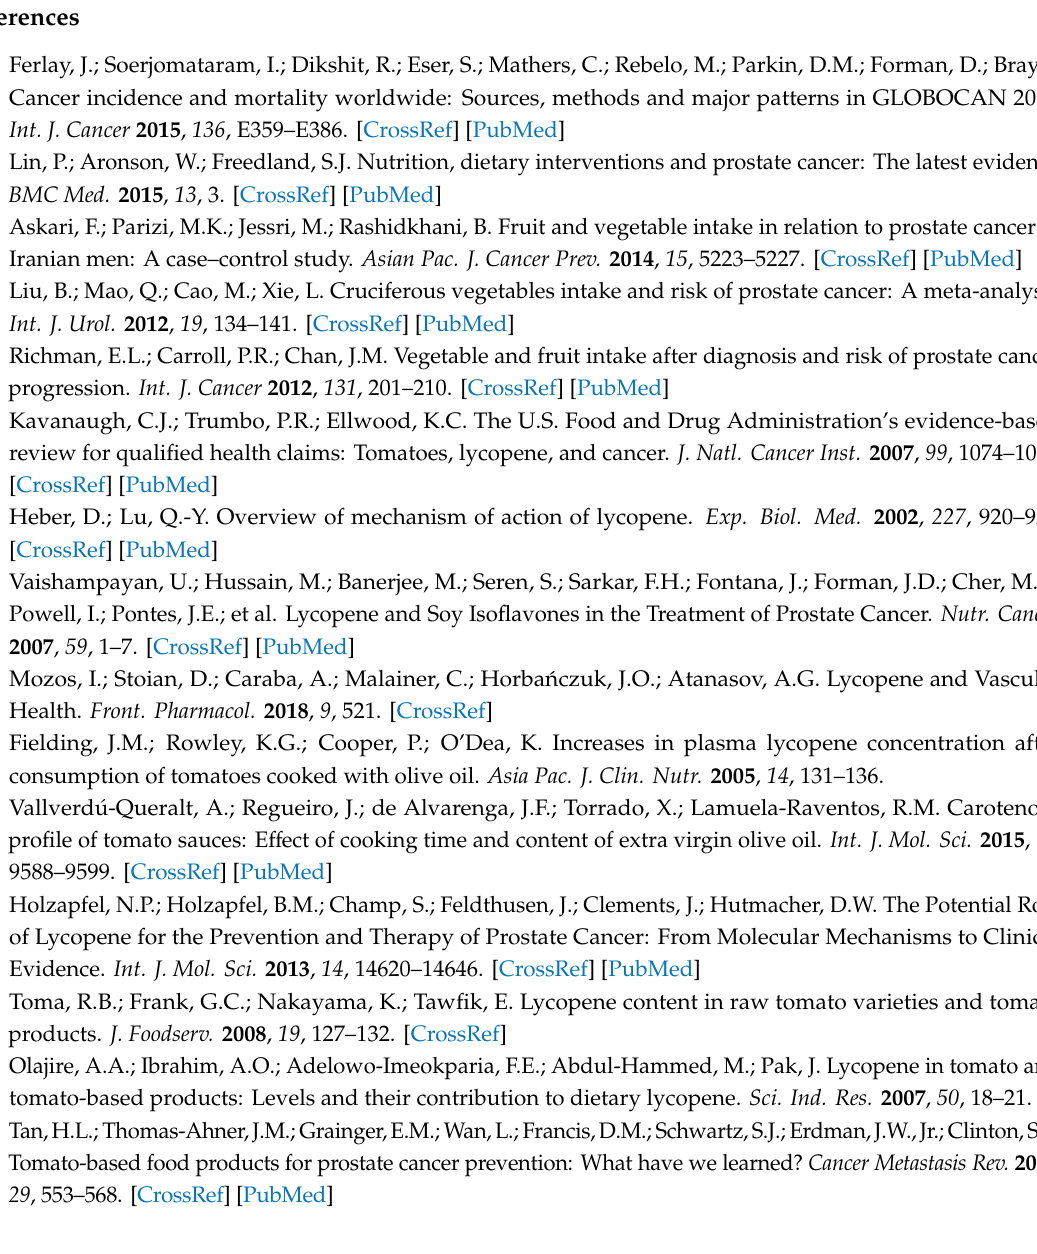
Figure S1: HPLC analysis of lycopene standard and UV spectrum of all-trans-lycopene ( A ) and cis-lycopene ( B ); Figure S2. HPLC analysis of tomato extract ( A ), tomato paste ( B ), tomato sauce ( C ), and ketchup ( D